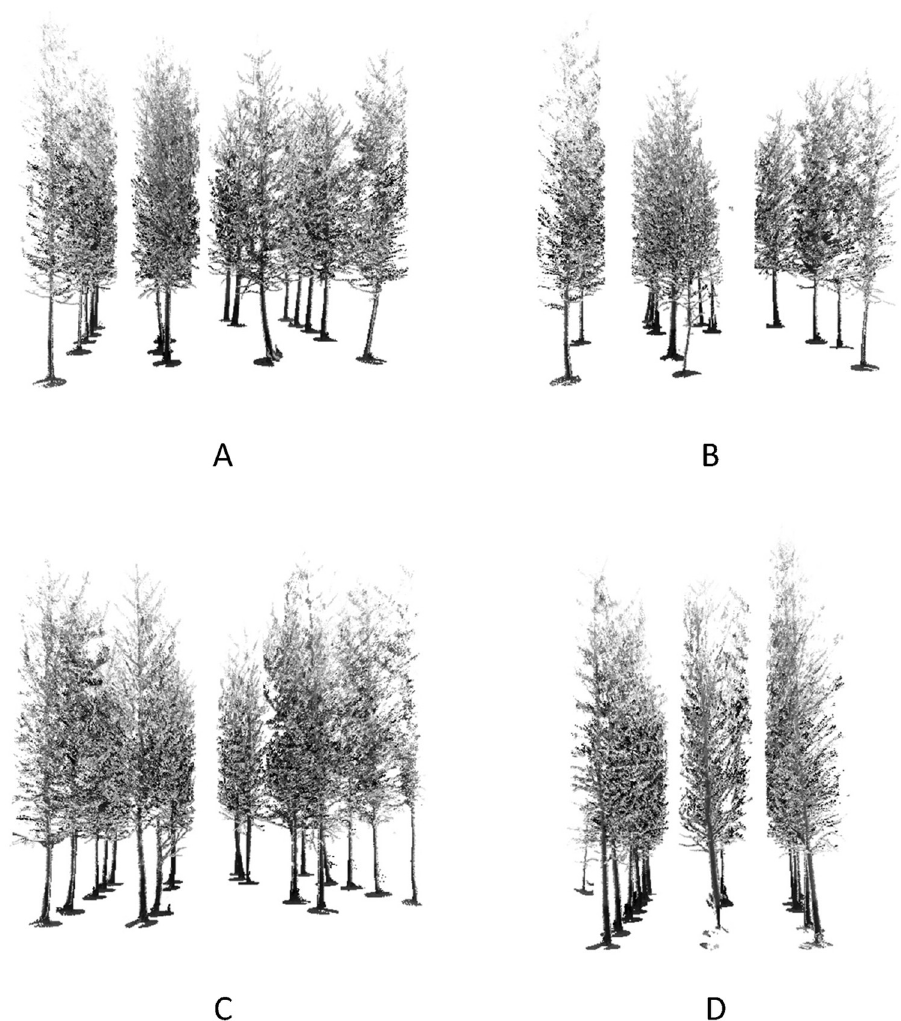
Fig 8. The detected trees of the four plots: (A) Plot 1, (B) Plot 2, (C) Plot 3, and (D) Plot 4.